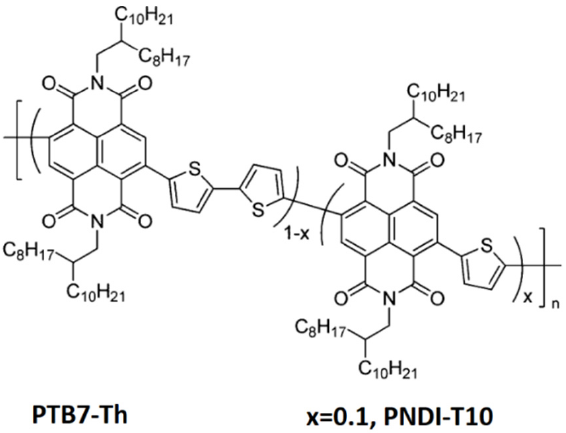
Figure 1. The structure of PTB7-Th polymer donor and PNDI-T10 acceptor polymer [39].